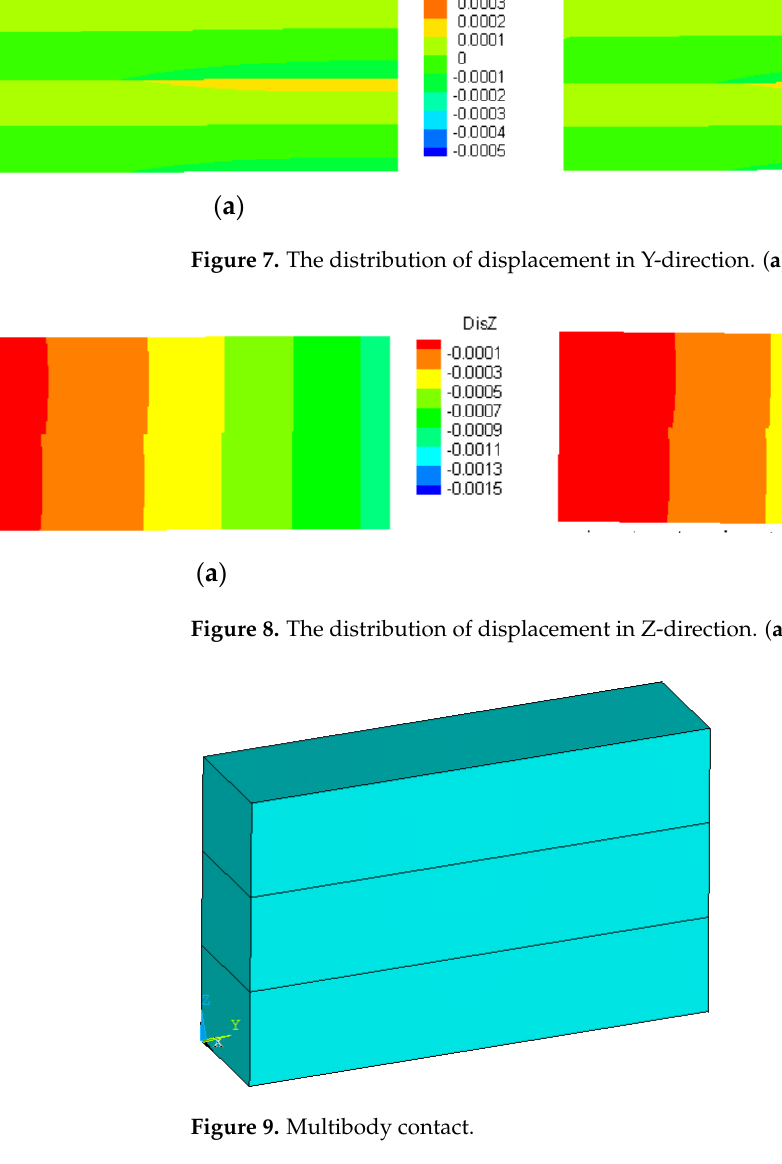
Figure 7. The distribution of displacement in Y-direction. ( a ) SBFEM. ( b ) ANSYS.